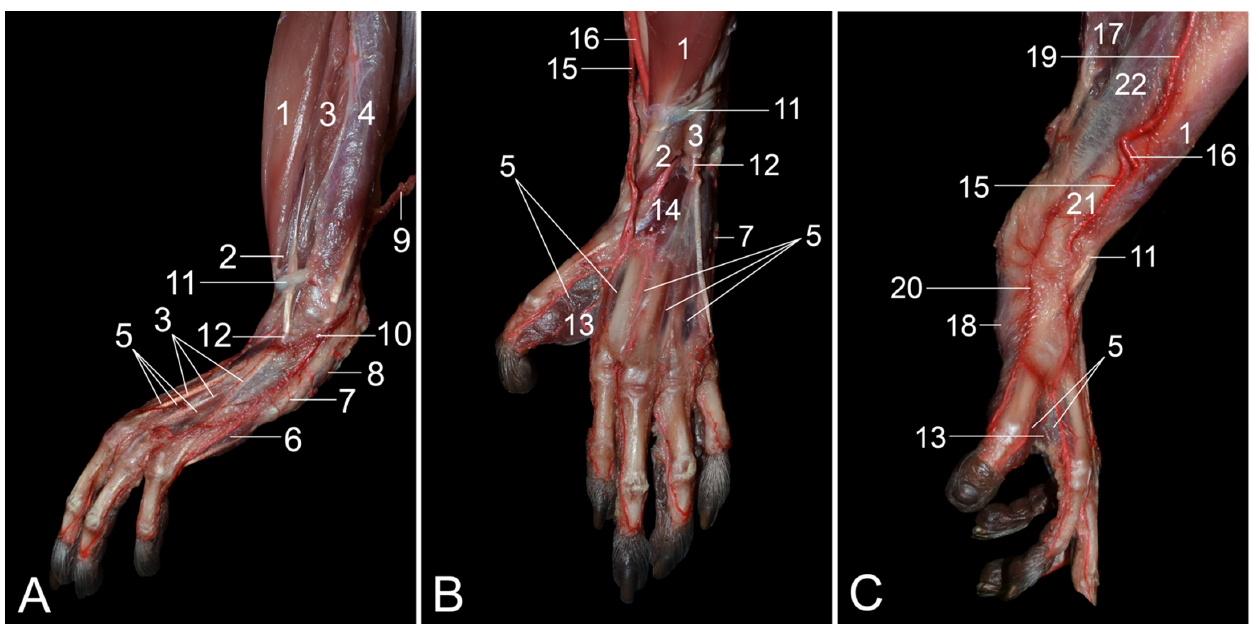
Figure 9. Lateral ( A ), dorsal ( B ) and medial ( C ) views of the left foot. 1: M. tibialis cranialis; 2: